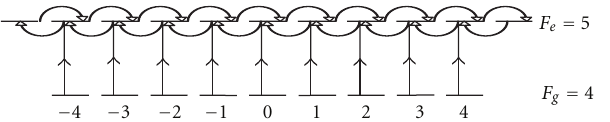
Figure 8: Illustration of the excited level magnetic sublevel population mixing involved by the elastic interactions between the Cs atoms and/or between Cs-atom and the cell windows when the atom is traveling parallel to the windows surface in the ETC.